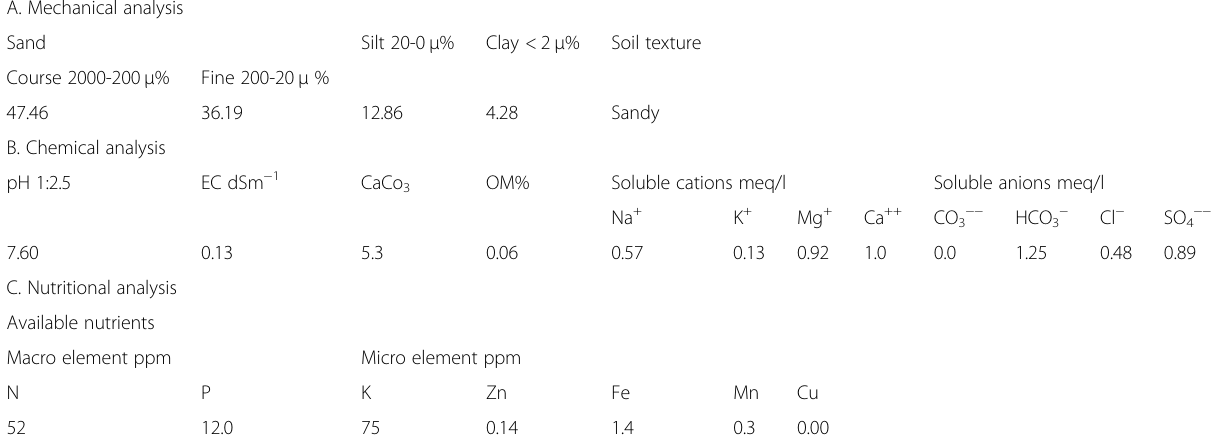
Table 1 Mechanical, chemical and nutritional analysis of the experimental soil